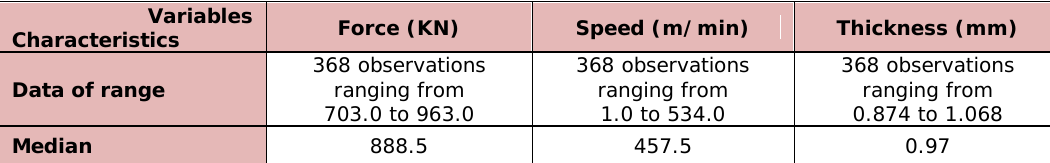
Table 1. “Range and median of force, speed, and thickness